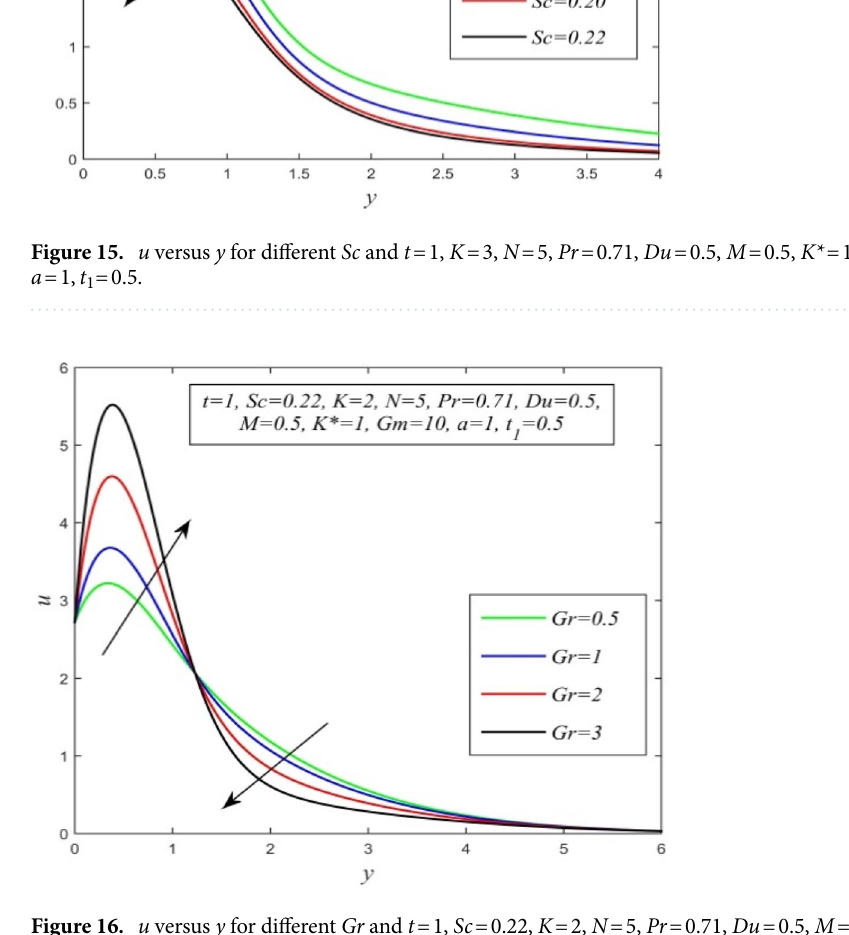
Figure 16. u versus y for different Gr and t = 1, Sc = 0.22, K = 2, N = 5, Pr = 0.71, Du = 0.5, M = 0.5, K* = 1, Gm = 10, a = 1, t 1 =